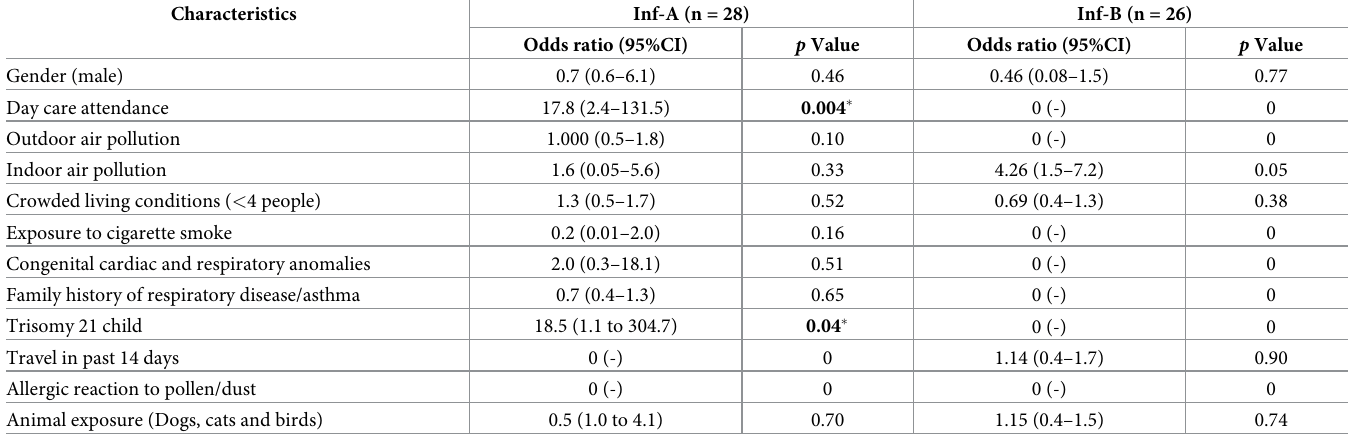
Table 2. Risk factors for acquiring Inf-V associated ARI in the study